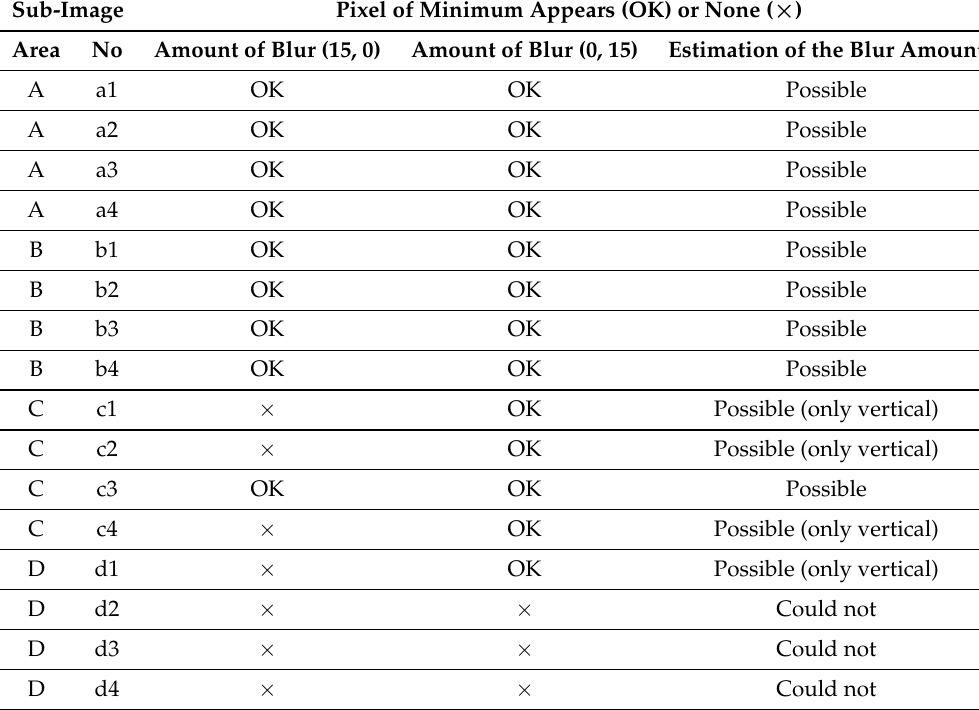
Table 8. The blur amount (15 pixels, 0 degrees and 90 degrees).